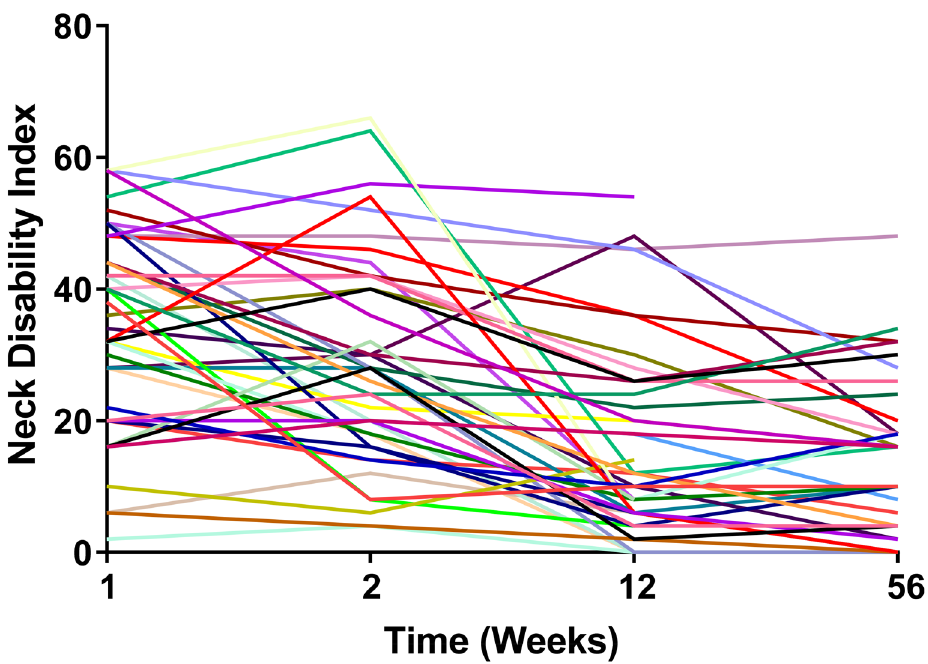
Figure 1. Graphical representation of neck-pain related disability index scores for each of the forty-three participants included in the current study analyses. Neck disability index questionnaires were administered at the time of enrollment following motor vehicle collision trauma (“week 1”), and at three subsequent timepoints over the course of a year (week 2, 12, and 56). Each line corresponds to a separate individual. These outcome trajectories served as the dependent variable in regression models assessing the relationship between microRNA and neck-related disability.